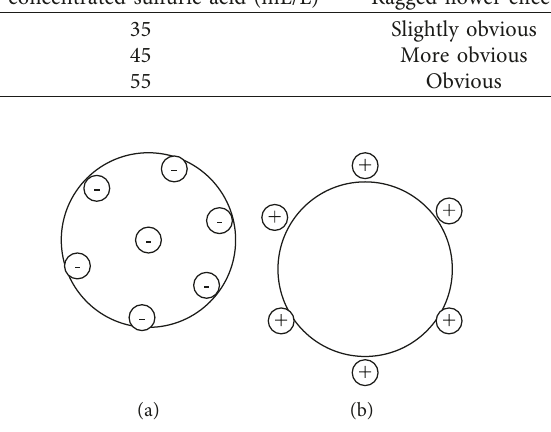
Figure 3: Jet ohmic resistance and jet surface